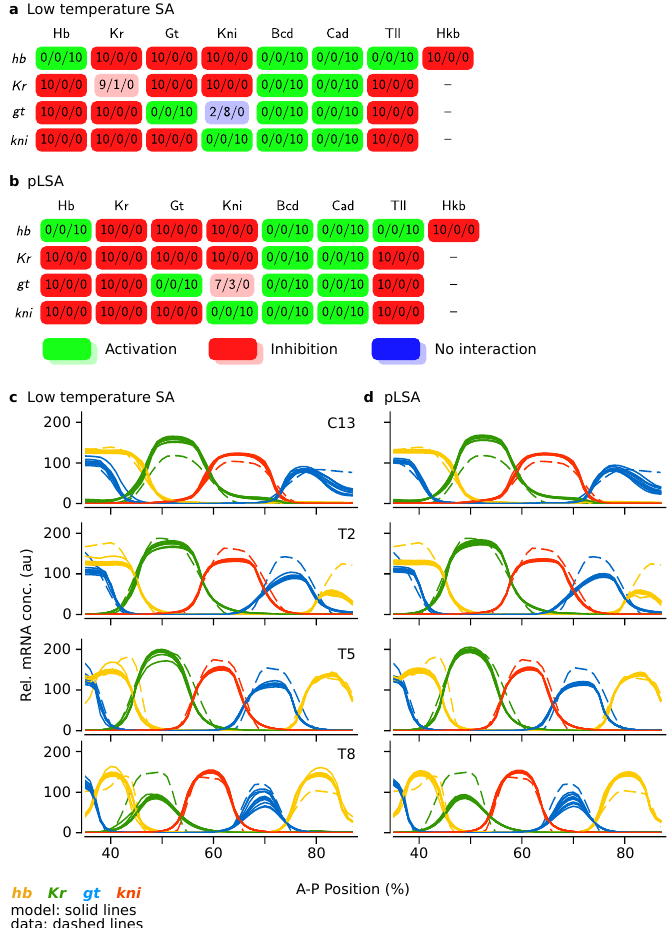
model: solid lines data: dashed lines Figure 7. Comparison of the best gene circuits resulting from low temperature Simulated Annealing (SA) and parallel Lam Simulated Annealing (pLSA). Panels ( a , c ) show scenario T = 50 k, and ( b , d ) show pLSA. ( a , b ) Genetic interaction matrices. See Figure 5 and main text for details; ( c , d ) Gene expression profiles at four time points. Gene circuit expression is given by solid lines, data by dashed lines. The embryo’s trunk region is shown, spanning 35–87% A–P position. Time points are mitotic cycle C13 and time classes of cycle C14A,